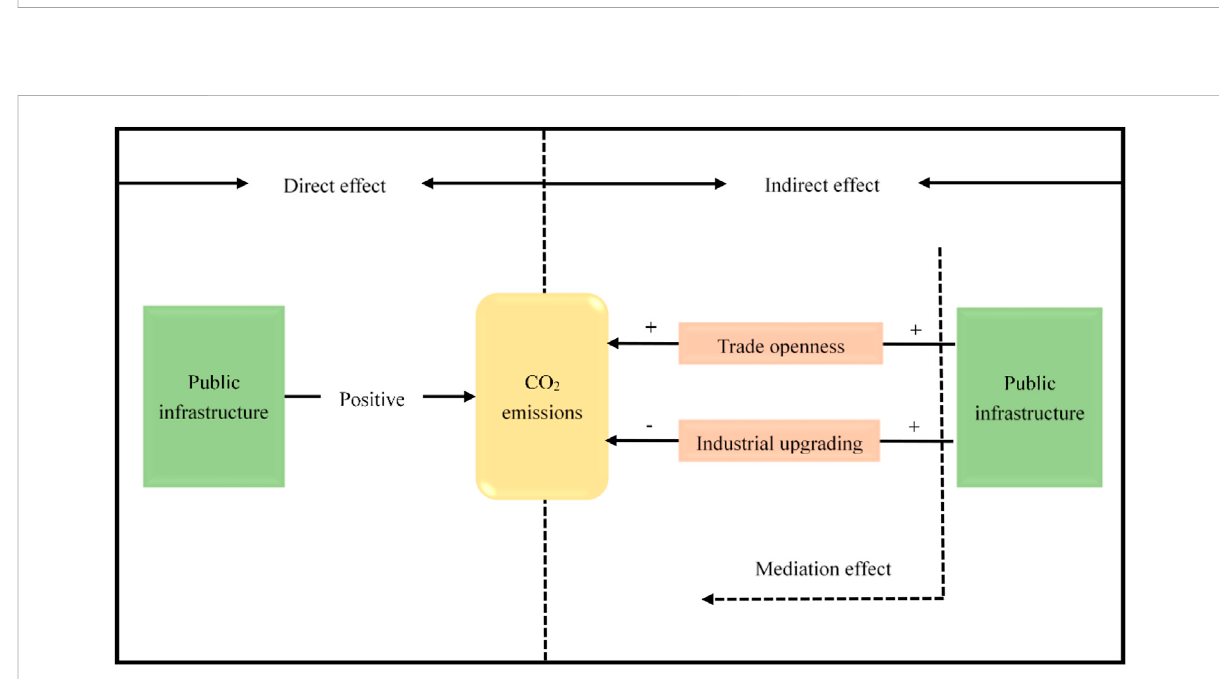
FIGURE 2 The transmission mechanism between infrastructure and CO 2